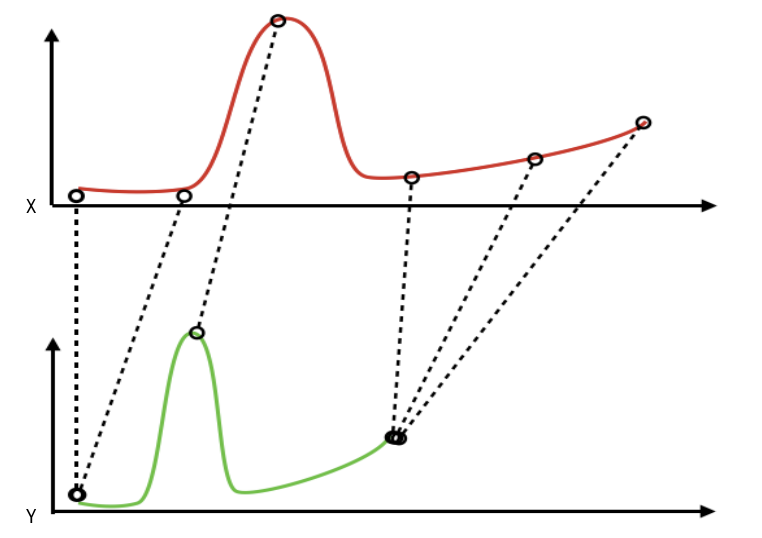
Figure 11. A dynamic time warping example for two hypothetical time series X and Y. The dashed lines indicate which sample from X aligns to which sample in